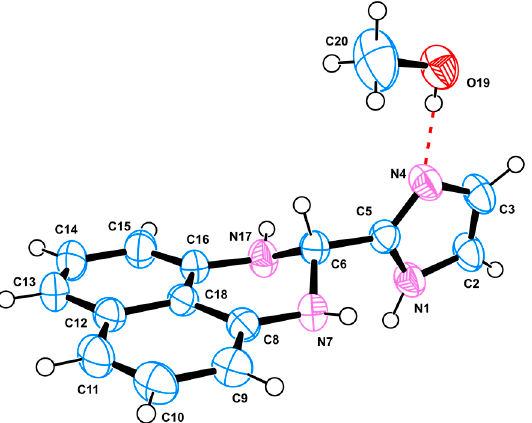
Figure 3. A representation of the molecules present in the asymmetric unit of the title compound along with the employed numbering scheme; atomic displacement parameters (ADP) are at 50% probability level, hydrogen atoms are shown as small spheres with arbitrary radii.